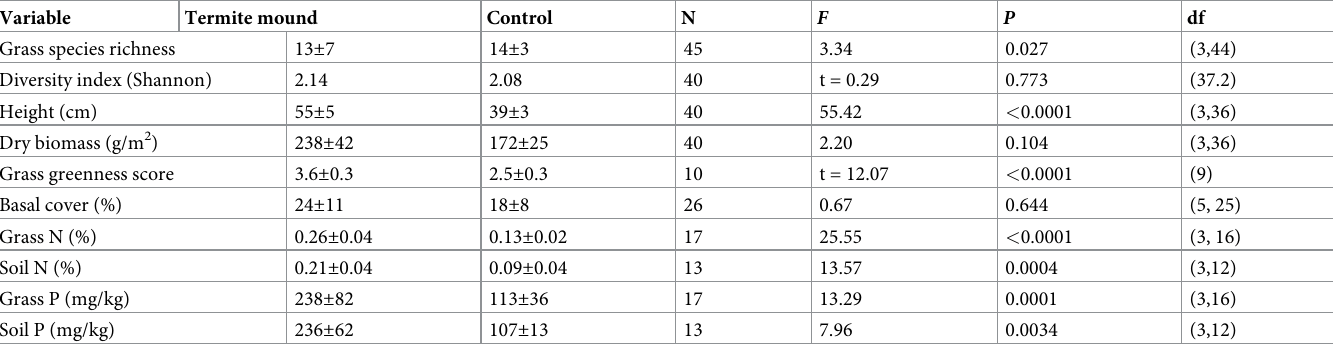
Table 3. Summary of variables assessed for grass and soil samples on termite mound sites vs control sites with their respective sample size (N), F value, P value, t value and degree of freedom (df) values. Grass height, biomass, cover, N and P values are shown as mean ± SD. Data were collected from May 2016 to October 2017 in the Issa Valley,